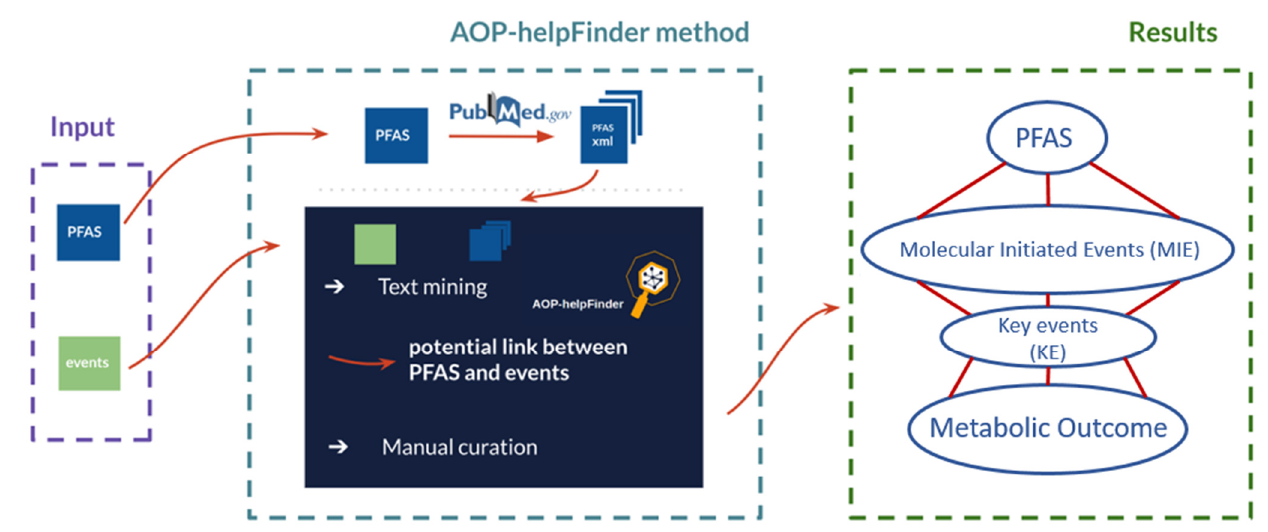
Figure 1. Workflow of the developed procedure to identify PFAS-mediated metabolic-related events. The proposed strategy is a multistep procedure: (1) Input: two lists (one with PFAS compounds and one with biological events (MIE, KE, and AO)) are needed as input data. (2) The AOP-helpFinder tool first extracts all available PubMed abstracts mentioning at least one PFAS from the first list. Then the tool retrieves biological events from the second list that are present in the selected abstracts and computes a distance score based on text mining and graph theory methods for prioritization. (3) As results, a linkage is proposed to help build AOPs induced by PFAS and related to metabolic outcomes.